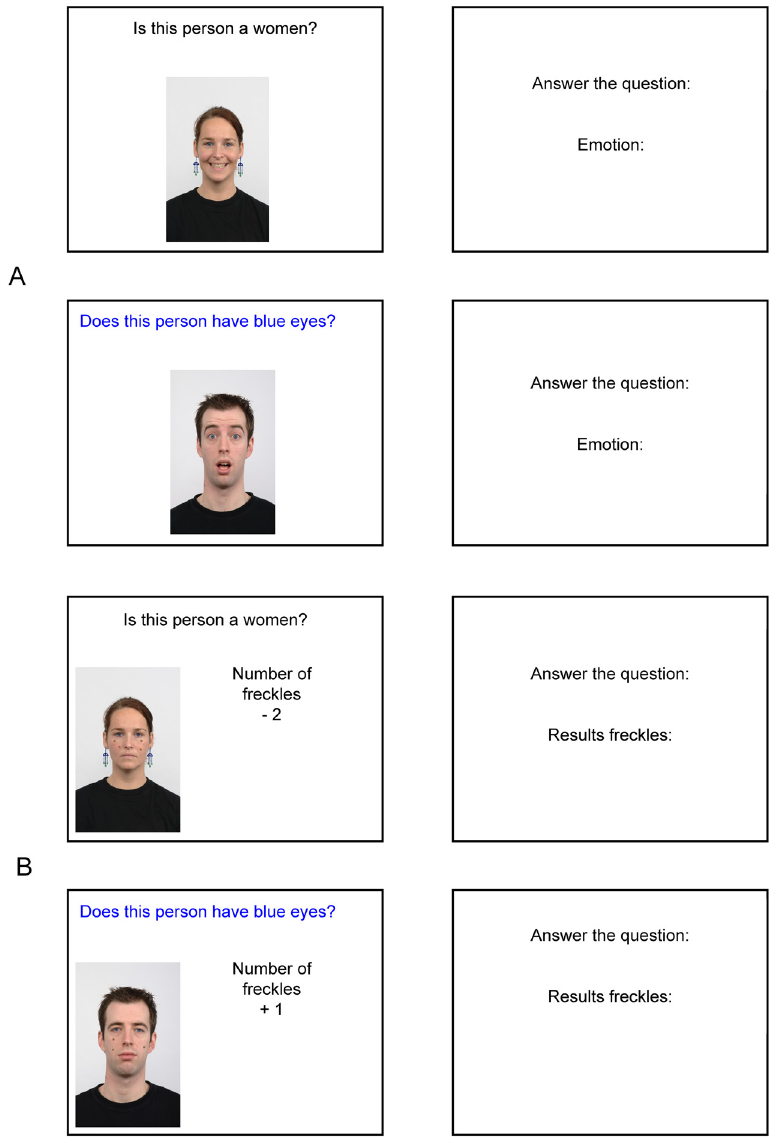
Fig 2. Double task example. Panel A shows an excerpt from Experiment 1 and panel B shows an excerpt from Experiment 2. Both contain two trials, consisting respectively of a question window (duration: 5 seconds) and answer window (duration: 6 seconds). At total each block consisted of 6 such successive trials from which one is colored blue. Whether participants responded with lying or saying ‘ blue question ’ on the blue question depended on the condition (lying, truth, intention). The two experiments differed with respect to their double task. The double task in Experiment 1 consisted of an emotion recognition task. In the excerpt from panel A participants were expected to say aloud ‘ Happy ’ and ‘ Surprised ’ , after having answered the question (e.g., ‘ Yes, this person is a woman. Happy ’ ). The double task in Experiment 2 consisted of an arithmetic task. In the excerpt from panel B, participants were expected to say aloud ‘ 2 ’ and ‘ 4 ’ after having answered the question in the answer window (e.g., ‘ Yes, this person is a woman. Two ’